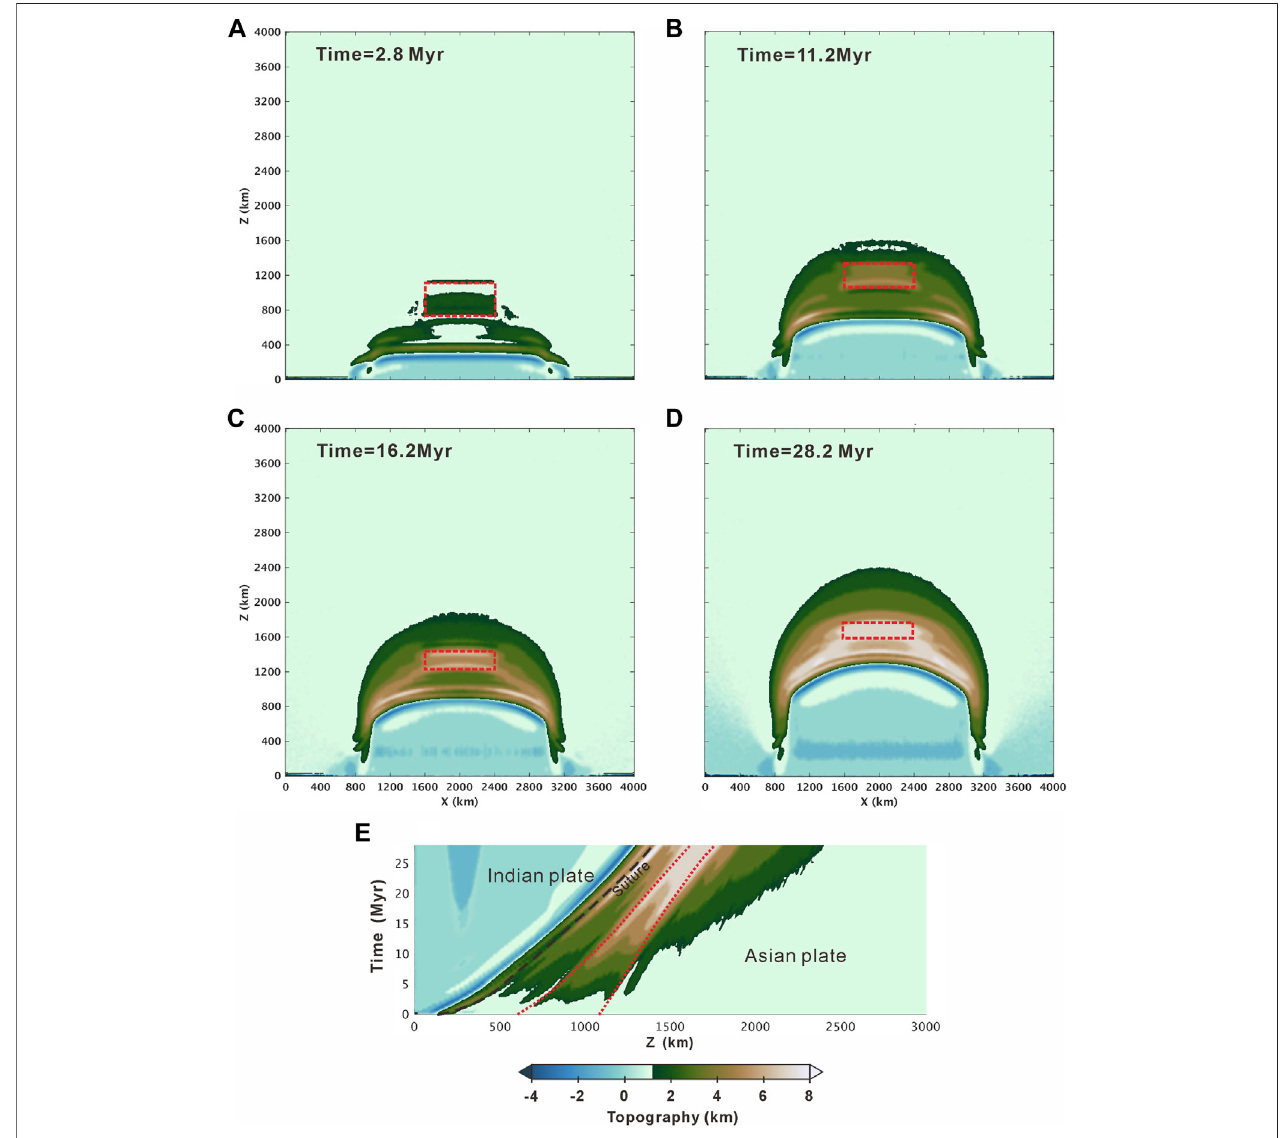
FIGURE 10 | Topographic evolution of the model-6 ( Table 2 ). Snapshots showing the surface topography at (A) 2.8 Myr (B) 11.2 Myr (C) 16.2 Myr, and (D) 28.2 Myr (E) display the topographic evolution with time along section x = 2,000 km.